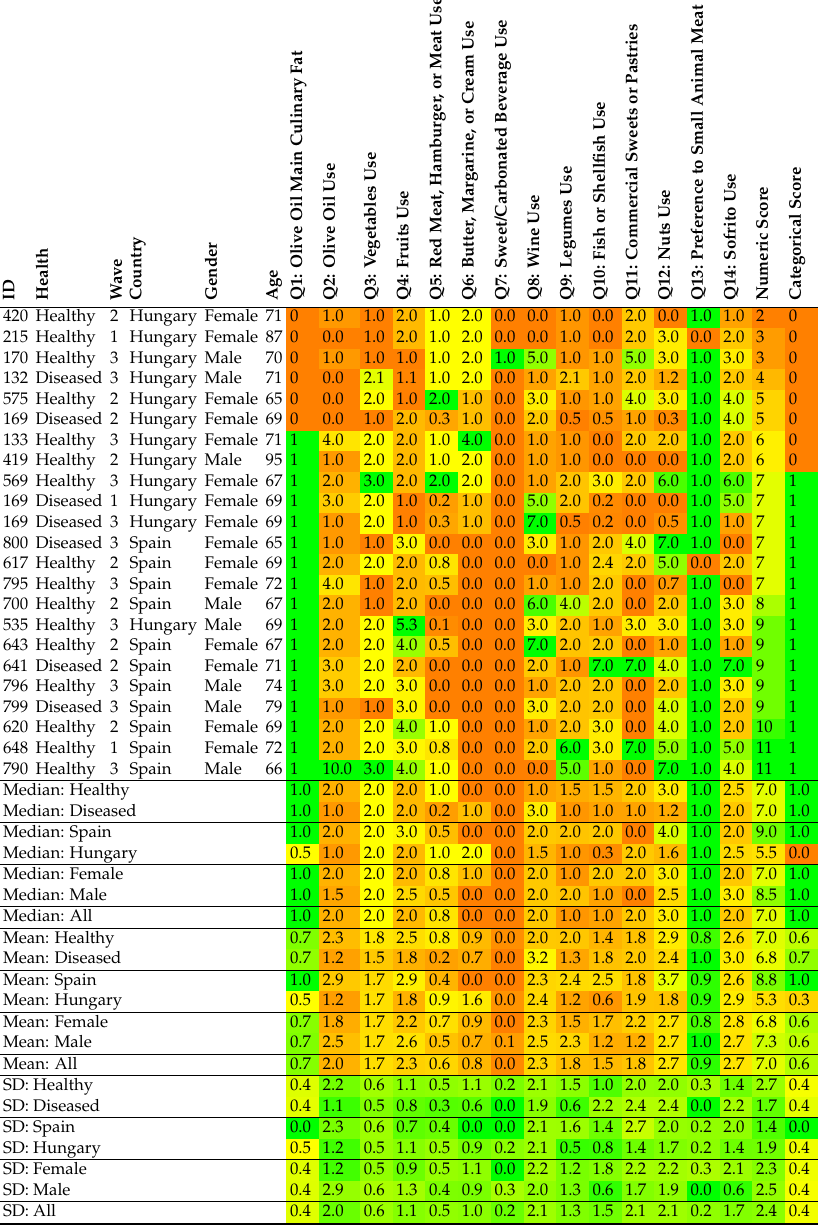
Color coding: from orange (worse outcome relative to others) to yellow to green (better